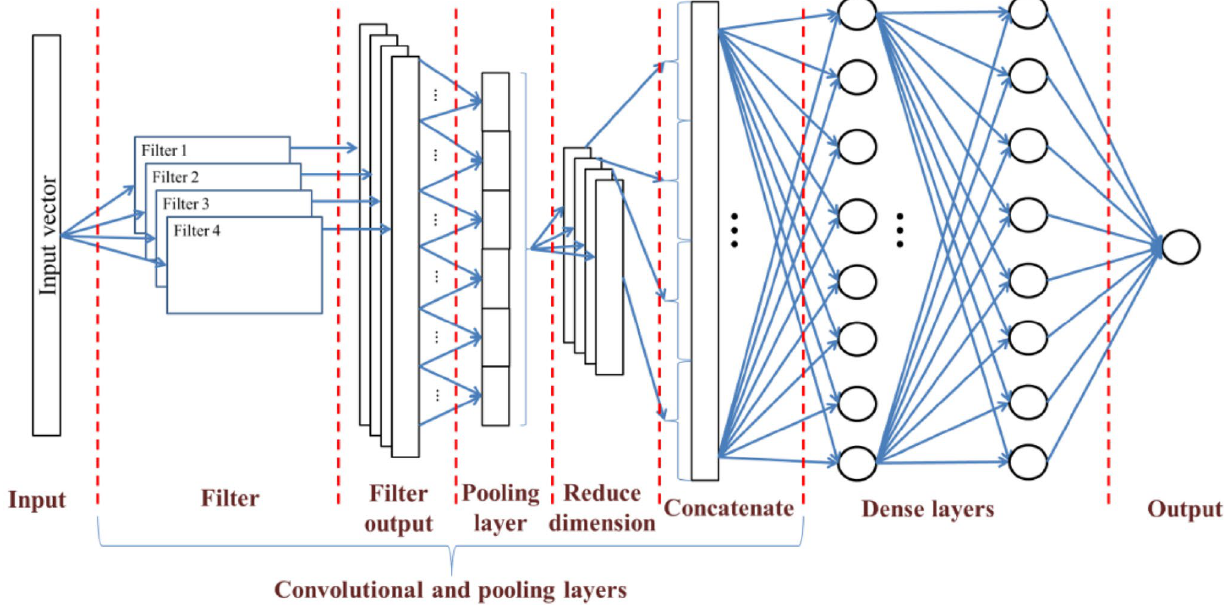
Fig. 16 Structure of a CNN (Mehrad et al.